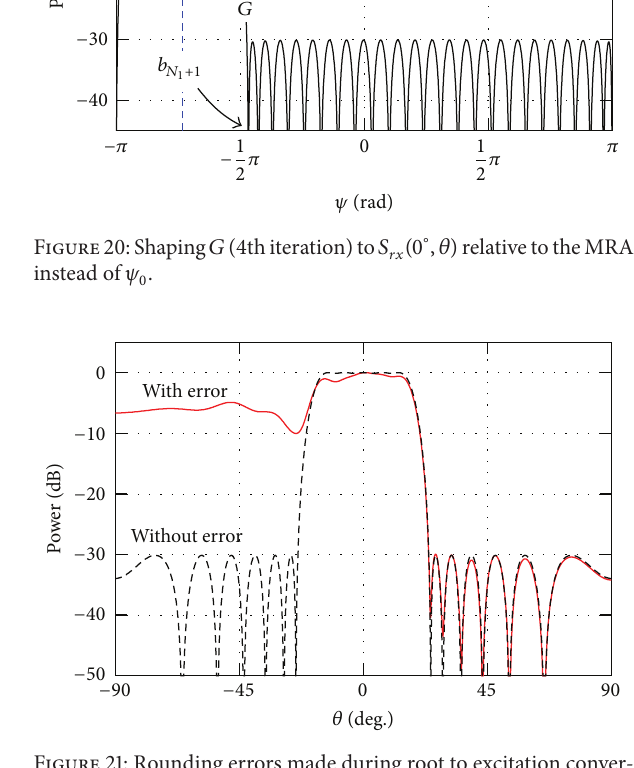
Figure 21: Rounding errors made during root to excitation conver- sion may lead to an unusable pattern